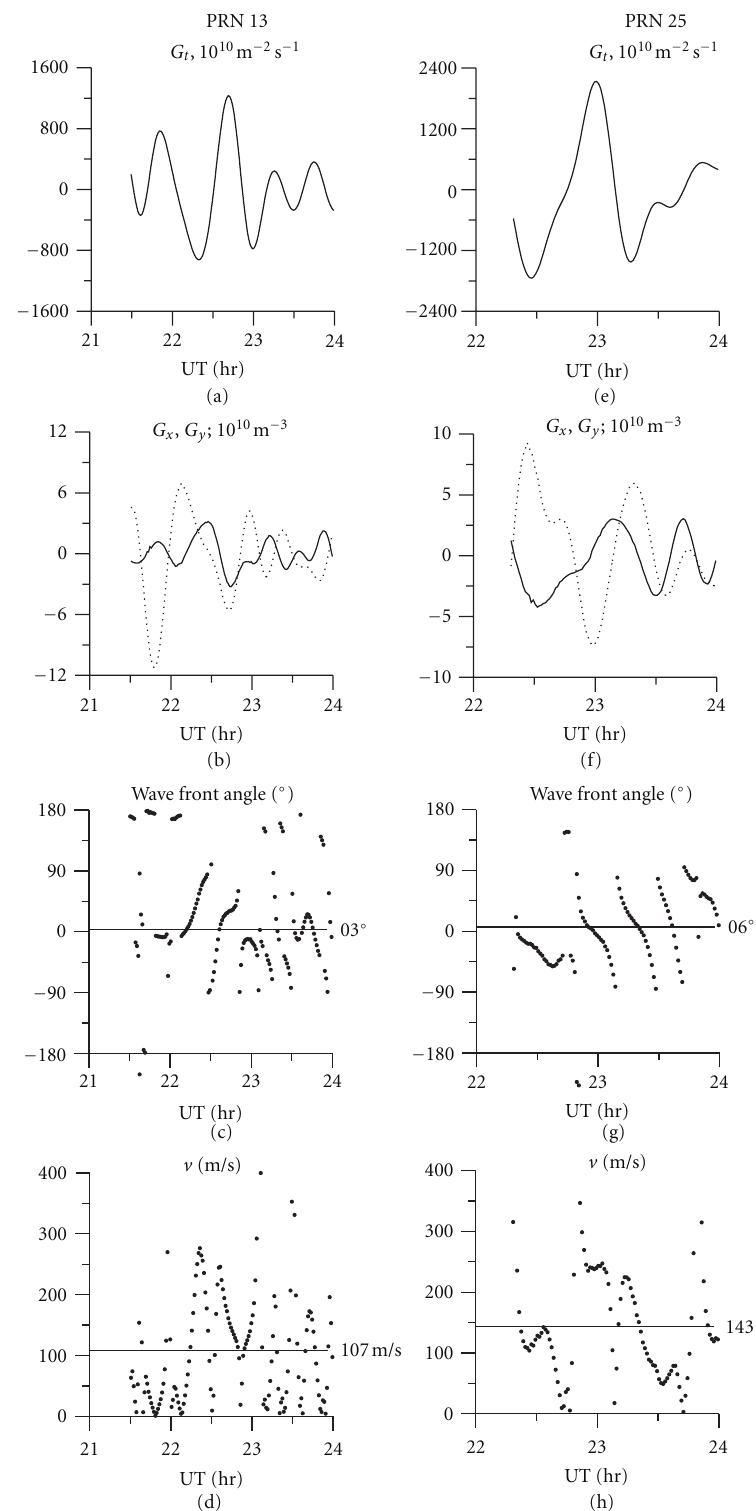
Figure 4: Derivation of di ff erent parameters used by the SADM-GPS method for GPS satellites 13 and 25. Panels (a) and (e) show G t ; (b) and (f) G x solid curve and G x , dots; panels (c) and (g) show the direction of propagation α ( t ); (d) and (h) present the horizontal velocity, t V h (